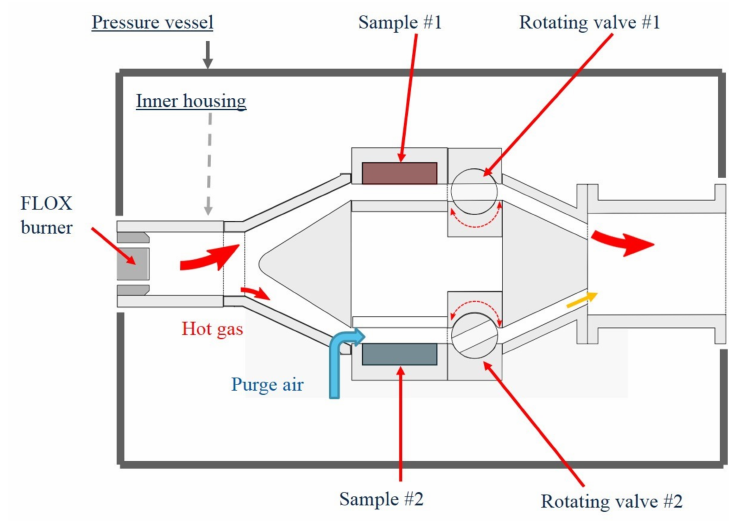
Figure 2. Test section